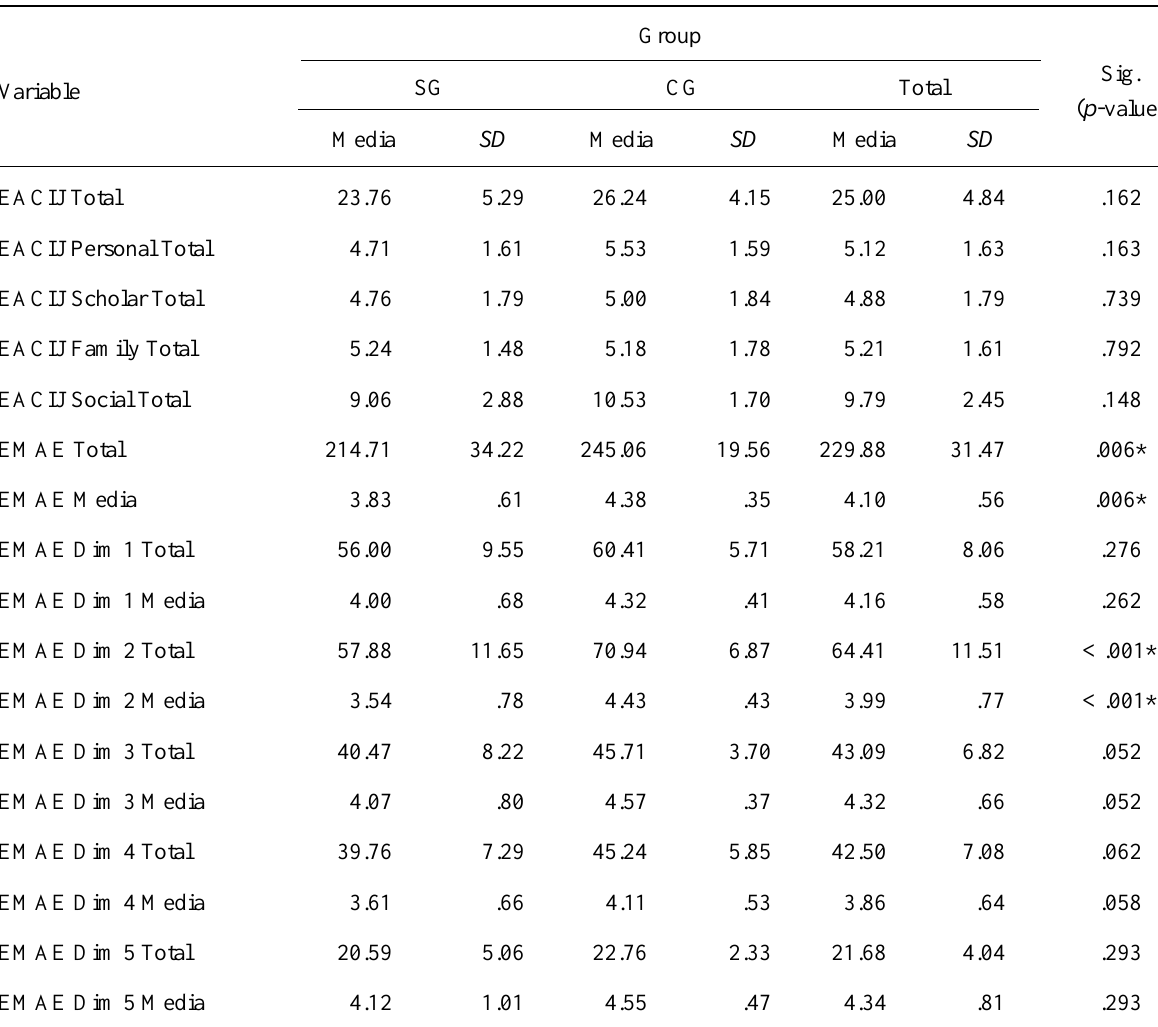
Group -value)SG CG Total